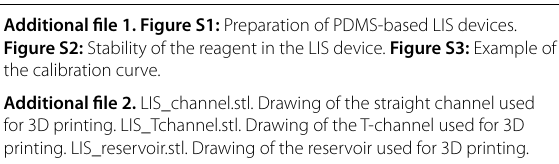
Additional file 1. Figure S1: Preparation of PDMS-based LIS devices. Figure S2: Stability of the reagent in the LIS device. Figure S3: Example of the calibration